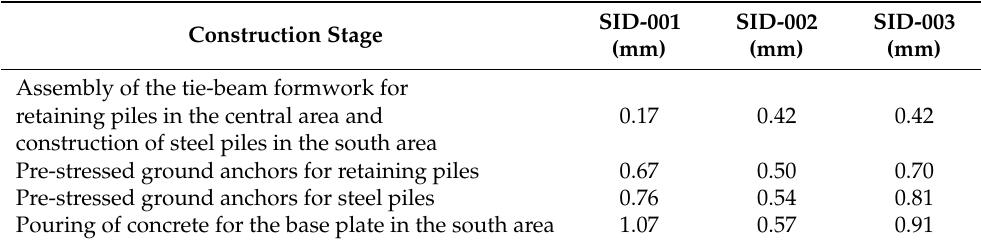
Table 3. Maximum displacement measured by the inclinometers (SID) in each construction stage in the south